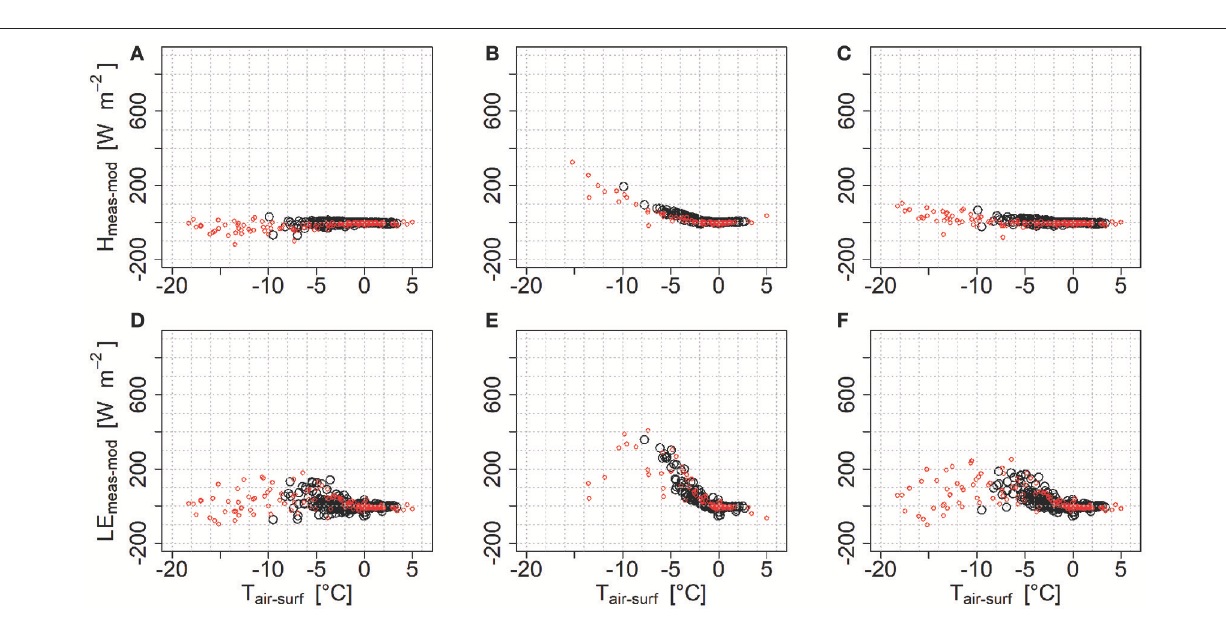
FIGURE 10 | Differences in modeled and observed sensible (A–C) and latent (D–F) heat fluxes compared to the temperature difference measured between surface and air for the model with no stability correction (A,D) , the model based on the Richardson number (B,E) and the model iterating over the Monin-Obukhov length (C,F) . Colors denote clear sky (red) and overcast (black)